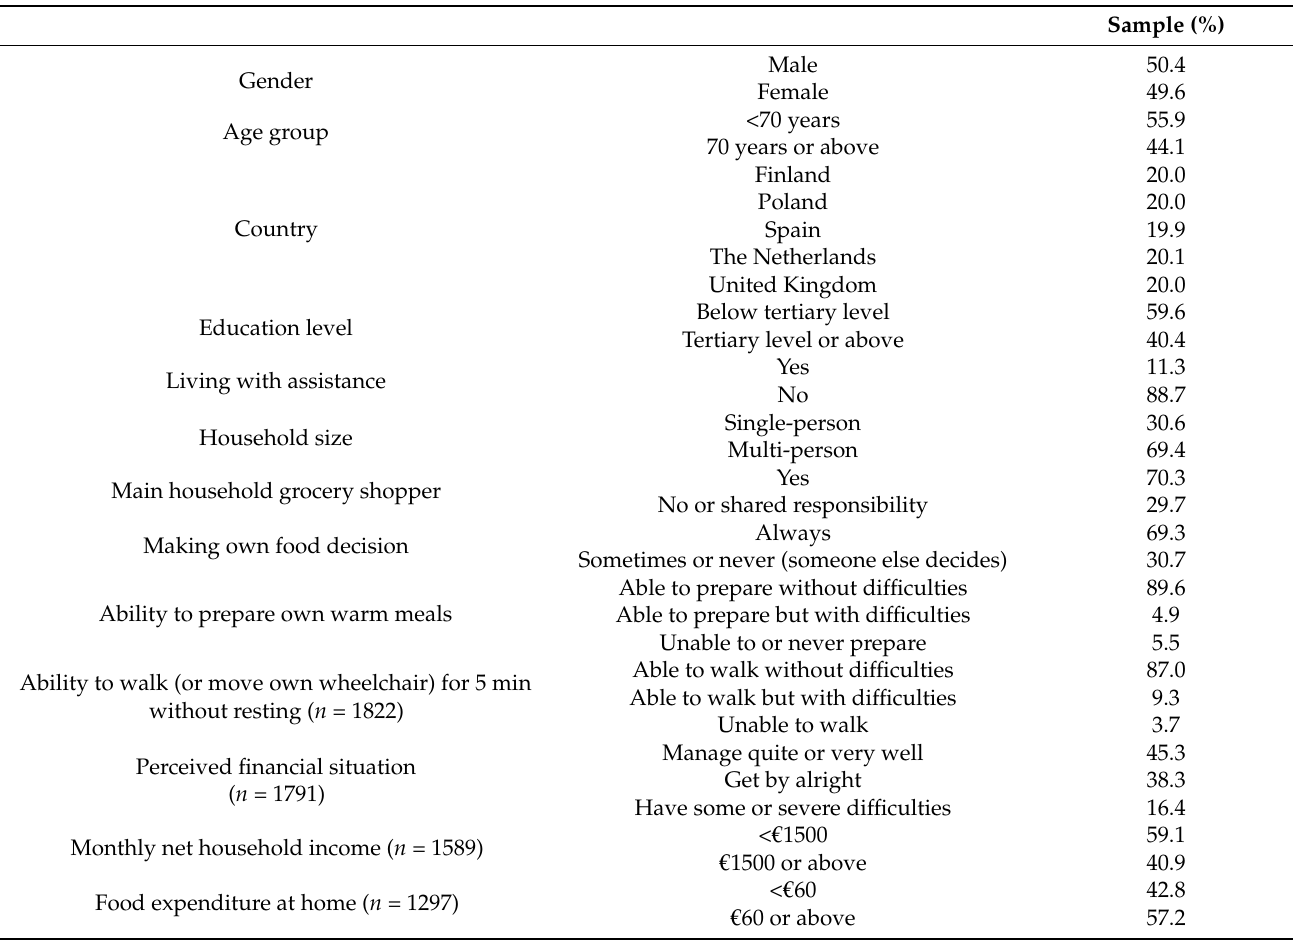
Table 1. Sample characteristics (% of respondents, n =